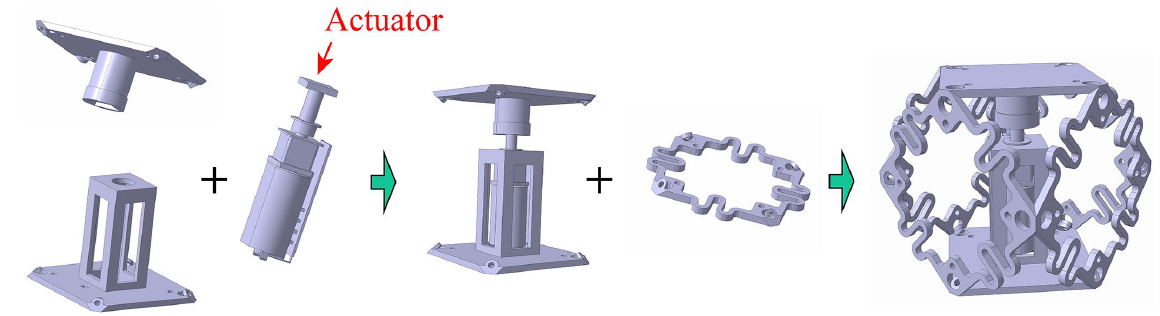
Figure 14. Assembly process of an active cell embedded with a micro-actuator.